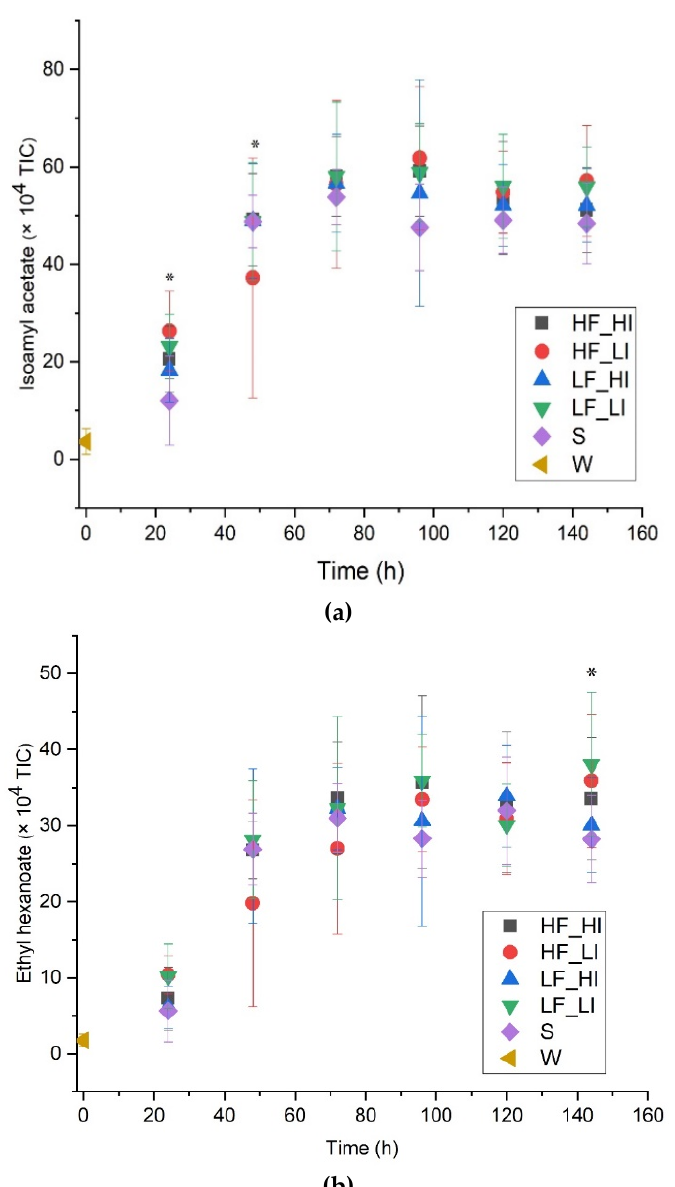
Figure 5. Abundance of esters during fermentation for five sound treatments, including a silent control. ( a ) Isoamyl acetate (A6); ( b ) ethyl hexanoate (A10). Low-frequency and low-intensity (LF_LI); low-frequency and high-intensity (LF_HI); high-frequency and low-intensity (HF_LI); high-frequency and high-intensity (HF_HI); silence (S); wort (W). The results shown are means ± standard deviations of six measurements (3 biological fermentation replicates × 2 analytical replicates). Total Ion Chromatogram (TIC). * Significant difference observed among treatments (Table